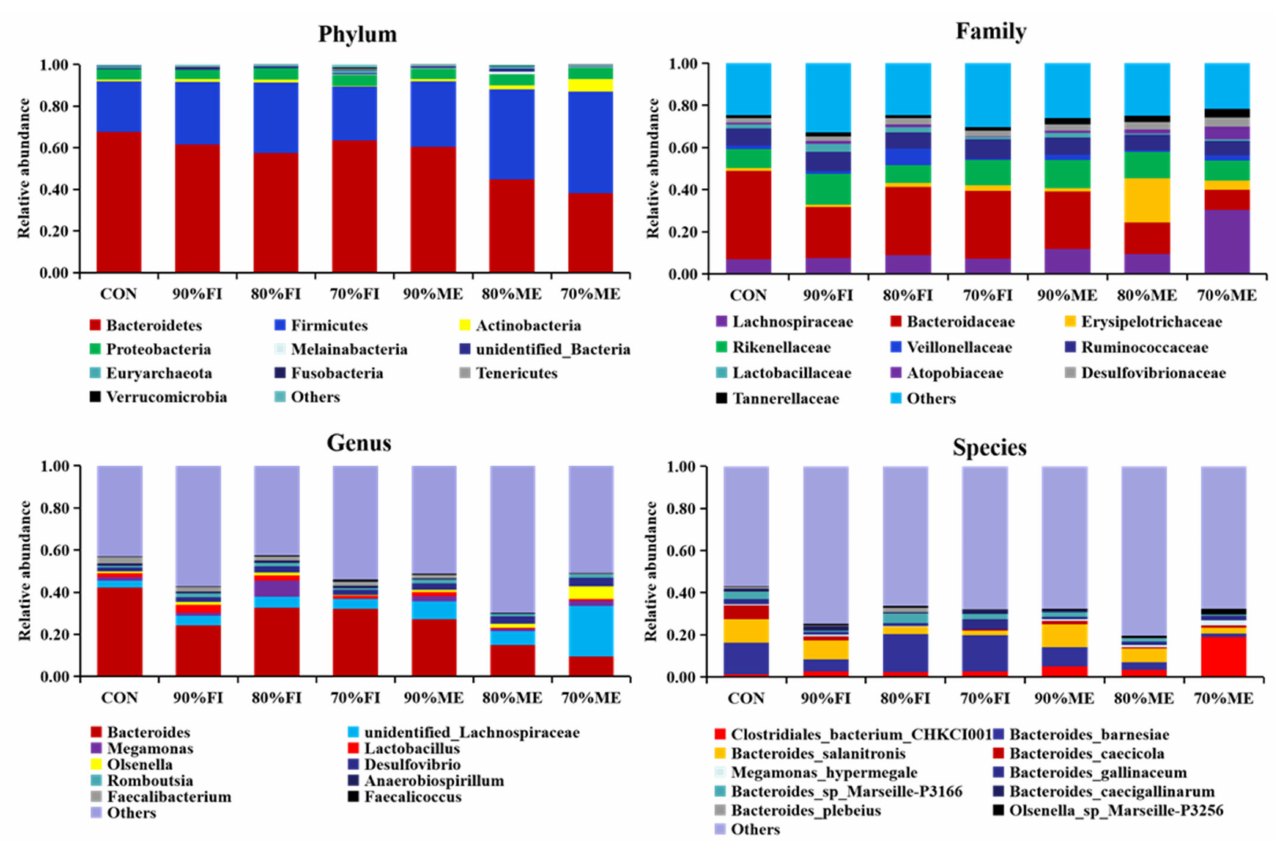
Figure 2. Composition and distribution of the microbiota at the phylum, family, genus, and species level. CON = fed with the basal diet ad libitum; 90% FI = fed with 90% feed intake of the CON; 80% FI = fed with 80% feed intake of the CON; 70% FI = fed with 70% feed intake of the CON; 90% ME = fed with 90% metabolizable energy of the CON; 80% ME = fed with 80% metabolizable energy of the CON; 70% ME = fed with 70% metabolizable energy of the